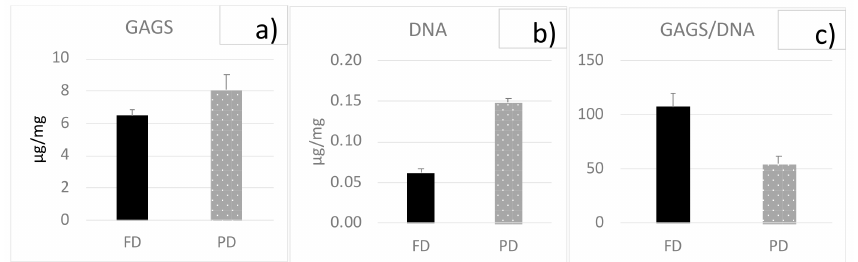
Figure 4. GAG and DNA contents for FD and PD samples, expressed as µ g/mg of wet weight: ( a ) GAG, ( b ) DNA, and ( c ) GAG-to-DNA ratio. Bars are standard